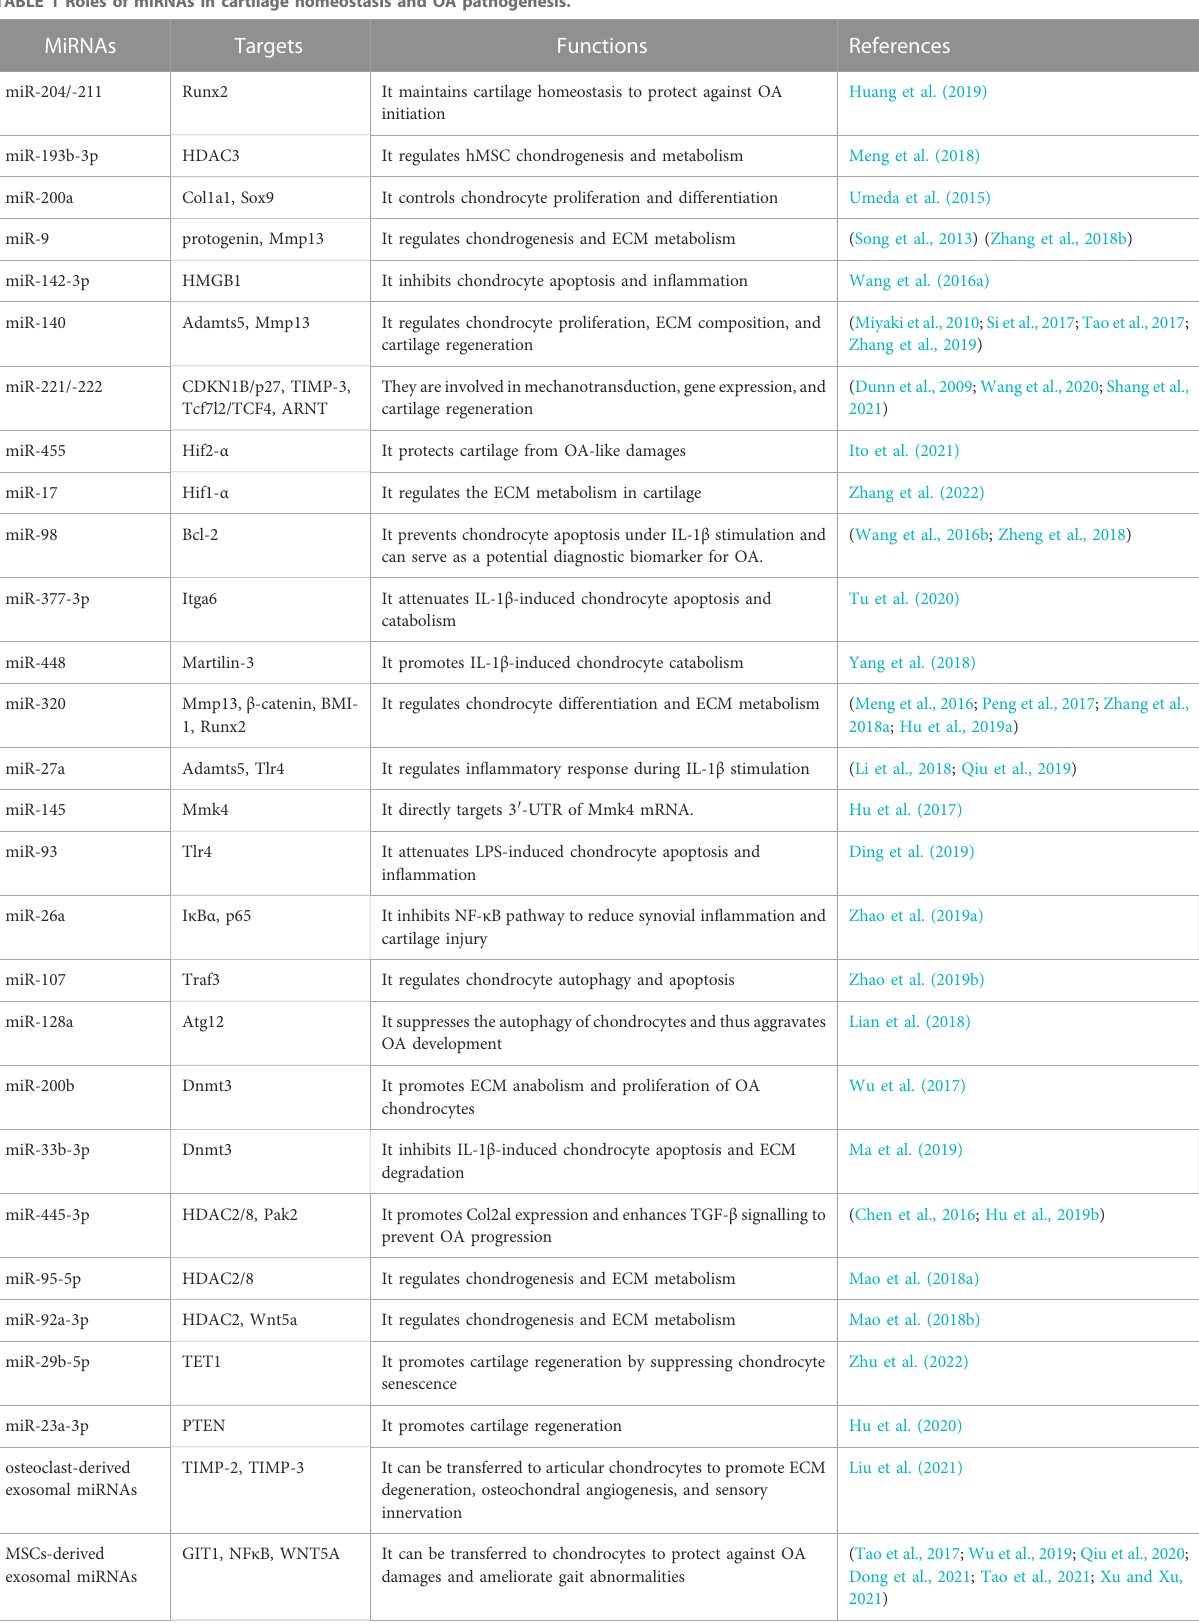
TABLE 1 Roles of miRNAs in cartilage homeostasis and OA